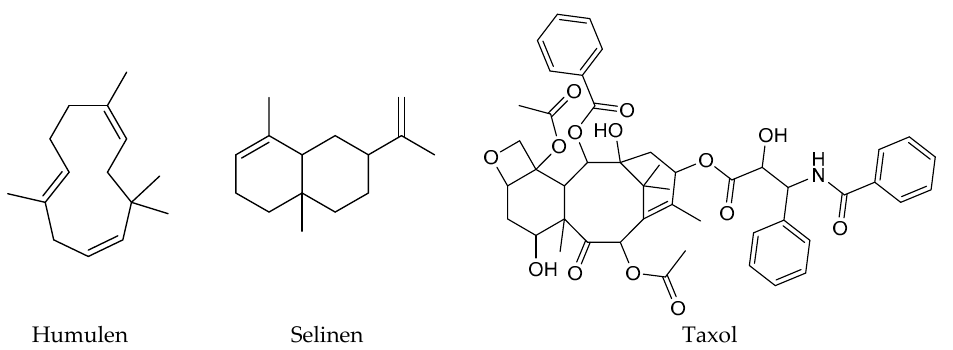
Taxol Figure 1. Furocoumarins and other phytoconstituents found in Apium plant leaves. Figure 1. Furocoumarins and other phytoconstituents found in Apium plant The furocoumarins included celerin, psoralen, bergapten, apiumoside, apiumetin, apigravrin, osthenol, isopimpinellin, isoimperatorin, celereoside, and 5 ‐ and 8 ‐ hydroxy methoxypsoralen [105].